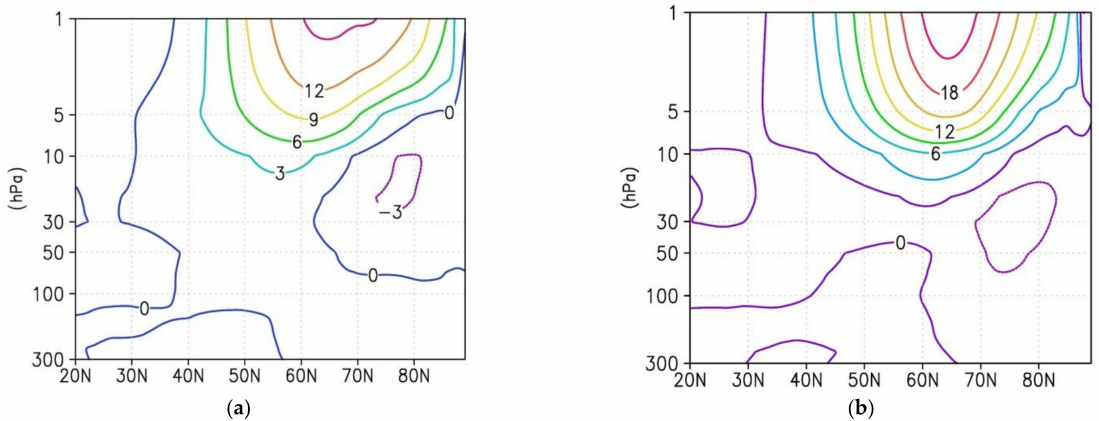
Figure 2. Difference of zonal mean meridional heat flux (K m/s) averaged over December–February between two periods 2081–2100 and 2016–2035 for moderate ( a ) and severe ( b )